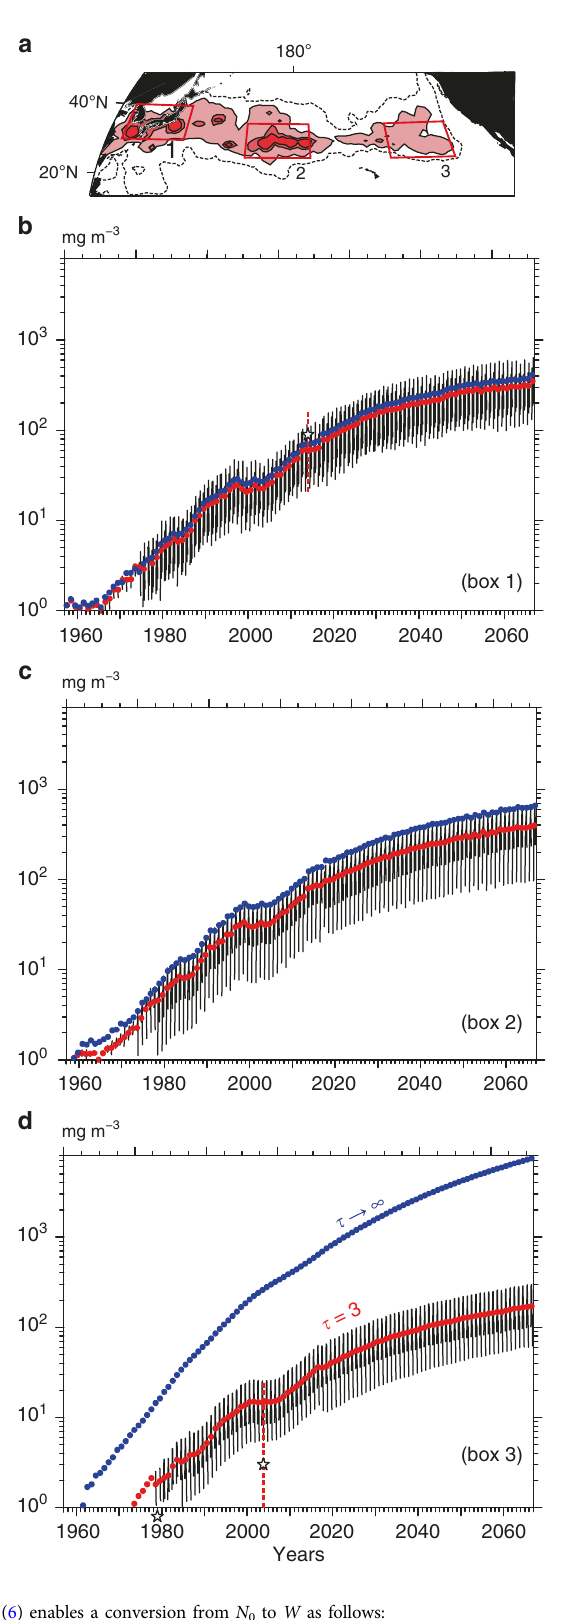
Supplementary Table 2. The positioning of the sources used in this study appears to be over-approximate, and did not adequately capture the distribution of source drivers such as river mouths. The ultimate scope of the present model was, therefore, to reproduce the order of magnitude of microplastic occurrence in different broad Paci fi c regions. At the time of the study, we had no way of knowing where and how microplastics are generated in the real world and, therefore, we assumed that macroplastic debris dumped in regions (i.e., countries constituting each source; Supplementary Table 2) was fragmentized to microplastics within the same region. In other words, microplastics fragmentized from macroplastic debris moving from remote regions, and/or those fragmentized from macroplastic debris